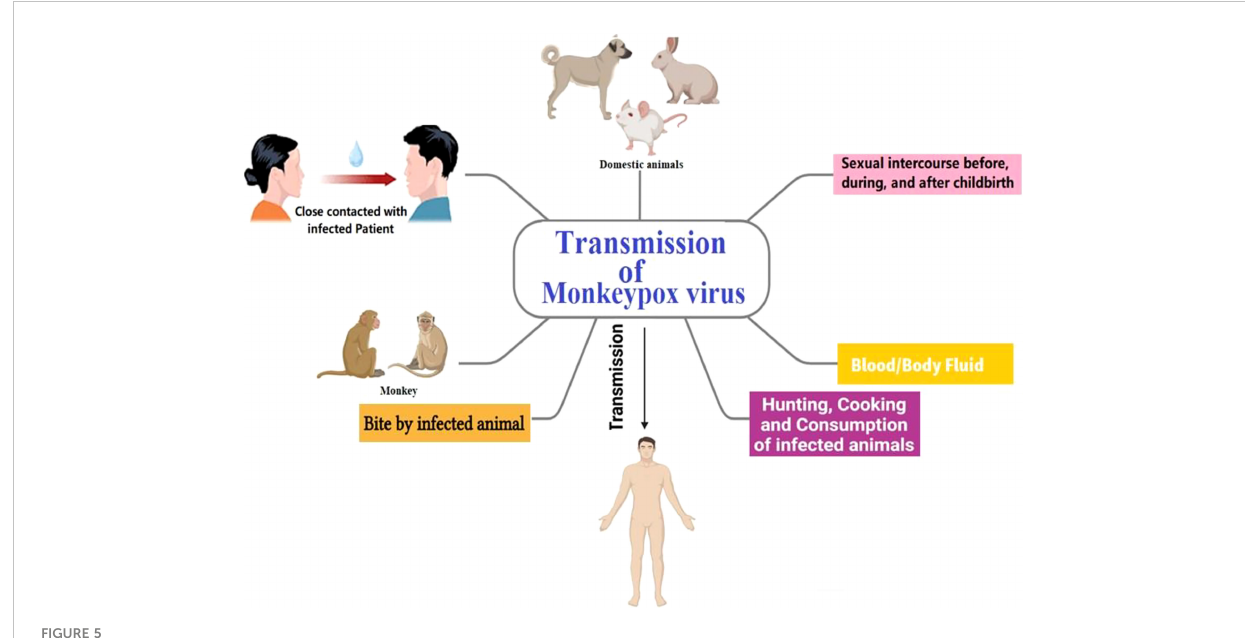
FIGURE 5 Monkeypox transmission pathway.